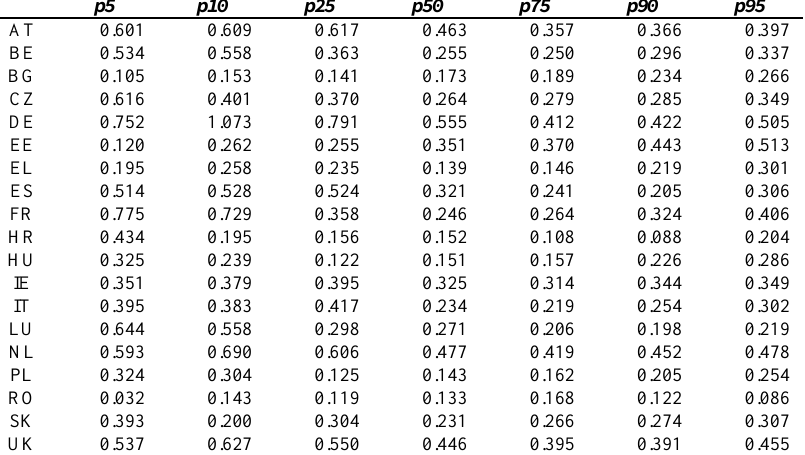
Table 4. The total differences between the log incomes along the